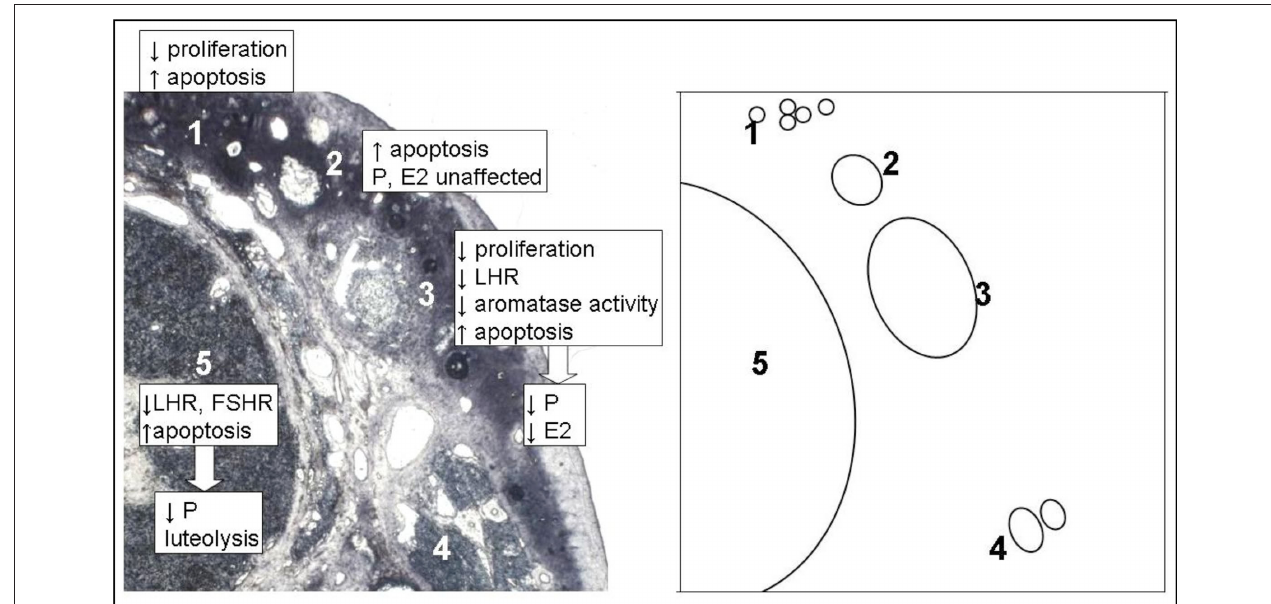
FIGuRe 1 | Theoretical construct of local gonadotropin-releasing hormone (GnRH) action on follicular development in the mammalian ovary, based on experimental evidence. GnRH and GnRH receptor (GnRH-R) are expressed on granulosa cells at all stages of follicular development and on granulosa-luteal cells of corpora lutea. Prehierarchical follicles (1) are not stimulated by Follicle stimulating hormone (FSH) and gonadal GnRH reduces granulosa cell numbers by reducing proliferation and increasing apoptosis in these follicles (Takekida et al., 2003). As follicles gain the ability to respond to FSH, they overcome this inhibition and grow into small/medium hierarchical follicles (2). GnRH increases apoptosis of granulosa cells in these follicles, but this does not cause a significant reduction in the secretion of already low levels of estradiol (E2) and progesterone (P) (Takekida et al., 2003). FSH, P and E2 enhance the growth of these follicles into large hierarchical follicles (3). GnRH reduces granulosa cell proliferation, aromatase activity (Gore-Langton et al., 1981) and luteinizing hormone receptor (LH-R)